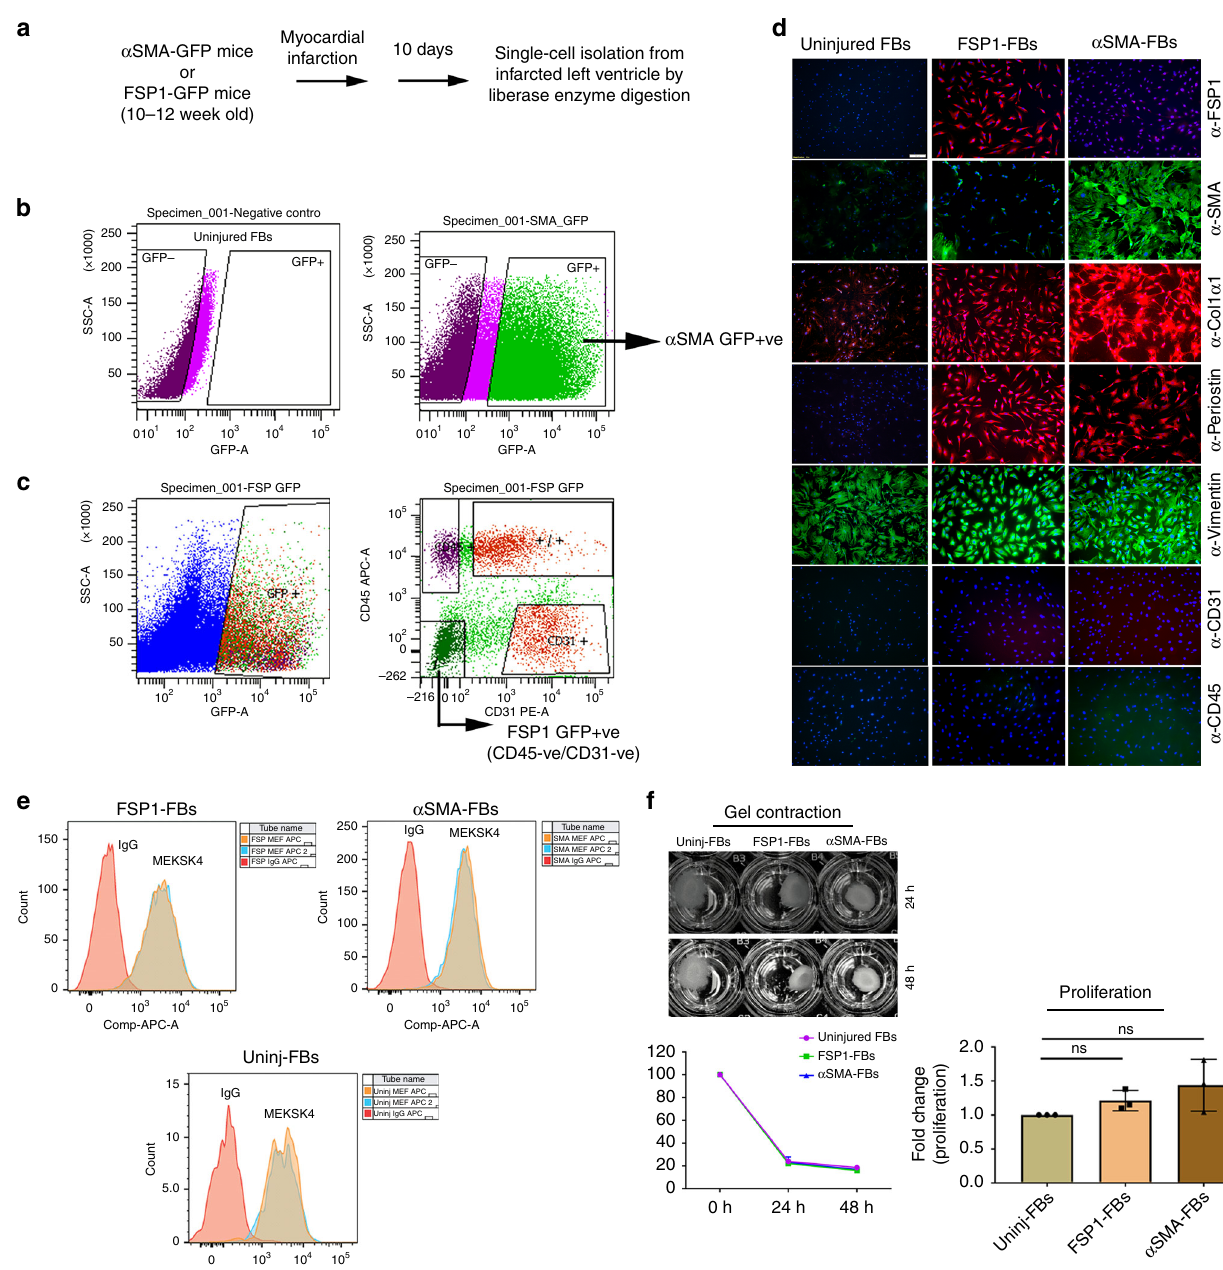
Fig. 2 FSP1 + and α SMA + cells exhibit the molecular phenotype and functionality of fi broblasts. a Schematic of activated fi broblast isolation 10 days post myocardial infarction (MI) from murine hearts. b , c Representative dot plot for fl uorescence assisted cell sorting (FACS) of FSP1-expressing (GFP + / CD31 − /CD45 − ) and α SMA-expressing (GFP + ) fi broblasts from FSP1-GFP and α SMA-GFP mice left ventricle 10 days after MI. Uninjured fi broblasts were used as unstained negative control. CD45 and CD31 antibodies were used to gate out hematopoietic and endothelial cells, respectively. d Immuno fl uorescence staining of GFP + populations (P0) from left ventricle of uninjured, FSP1-GFP, or α SMA-GFP sorted by FACS showed FSP1 + and α SMA + as unique fi broblast populations, which express fi broblasts markers, such as COL1 α 1, periostin, and vimentin, but not hematopoietic marker CD45 or the endothelial marker CD31. Nuclei were stained with DAPI ( n = 3). Scale bar = 100 µ M; ×10 magni fi cation. e Representative FACS overlay histogram of uninjured, FSP1 + , and α SMA + fi broblasts (P3 – P5) to evaluate expression of MEF-SK4. Rat IgG was used as negative control ( n = 2). f Representative picture of collagen gel contraction in the presence of uninjured, FSP1 + , and α SMA + fi broblasts (P3 – P5) (left panel, top). Percentage change in the initial gel area following 24 and 48 h of contraction in the presence of uninjured, FSP1 + , and α SMA + fi broblasts (left panel, bottom) ( n = 2). Fold change in proliferative ability of FSP1 + and α SMA + fi broblasts (P3 – P5) compared with uninjured fi broblasts measured by Brdu proliferation assay (right panel). ns p > 0.05 was calculated by one-way ANOVA, n = 3 experiments were performed; ns = not signi fi cant. Cell isolation and FACS were performed at least three independent times for staining and proliferation assay and two independent times for contraction assay and MEF-SK4 fl ow analysis. For each sorting, cells were isolated from pooled homogenates from three to four injured murine